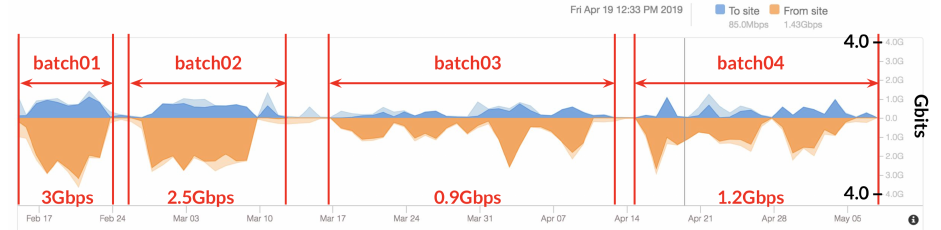
Figure 1. Data transfer rate to NERSC during processing of first 4 of 7 batches of RunPeriod2018-01 data. ( ∼ 55% of data from run period). Transfer rates during this time period were problematic and not stable largely due to contention for the Lustre file system used to stage files read from tape before transferring o ff site. The problems have since been corrected and we are now able to transfer data o ff site reliably at